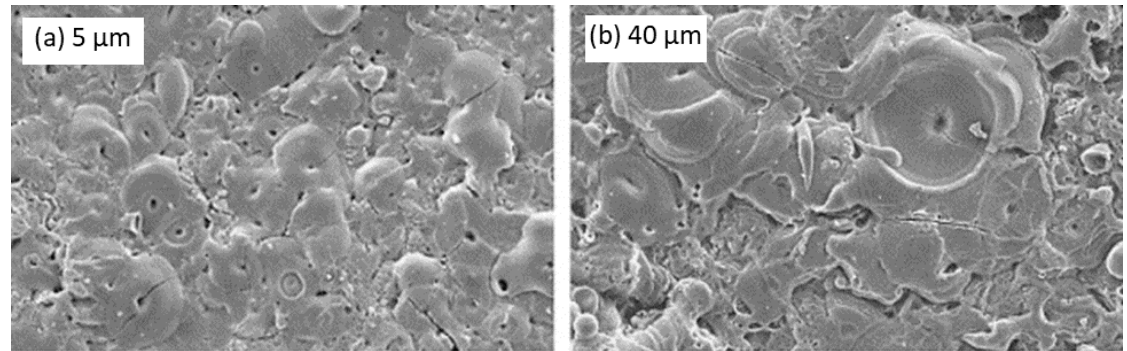
Figure 20. SEM micrographs of PEO coating on 6082 Al alloy developing coating thickness of ( a ) 5 μ m and ( b ) 40 μ m. Reproduced with permission from [152]. Copyright Elsevier, 2005.